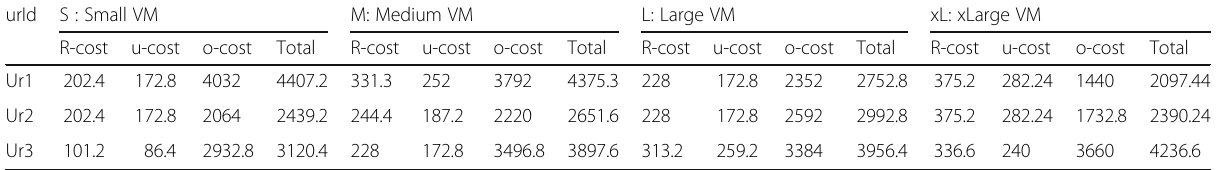
Table 8 A sample of users ’ total resource utilization cost with the coordinated provisioning approach urId S : Small VM M: Medium